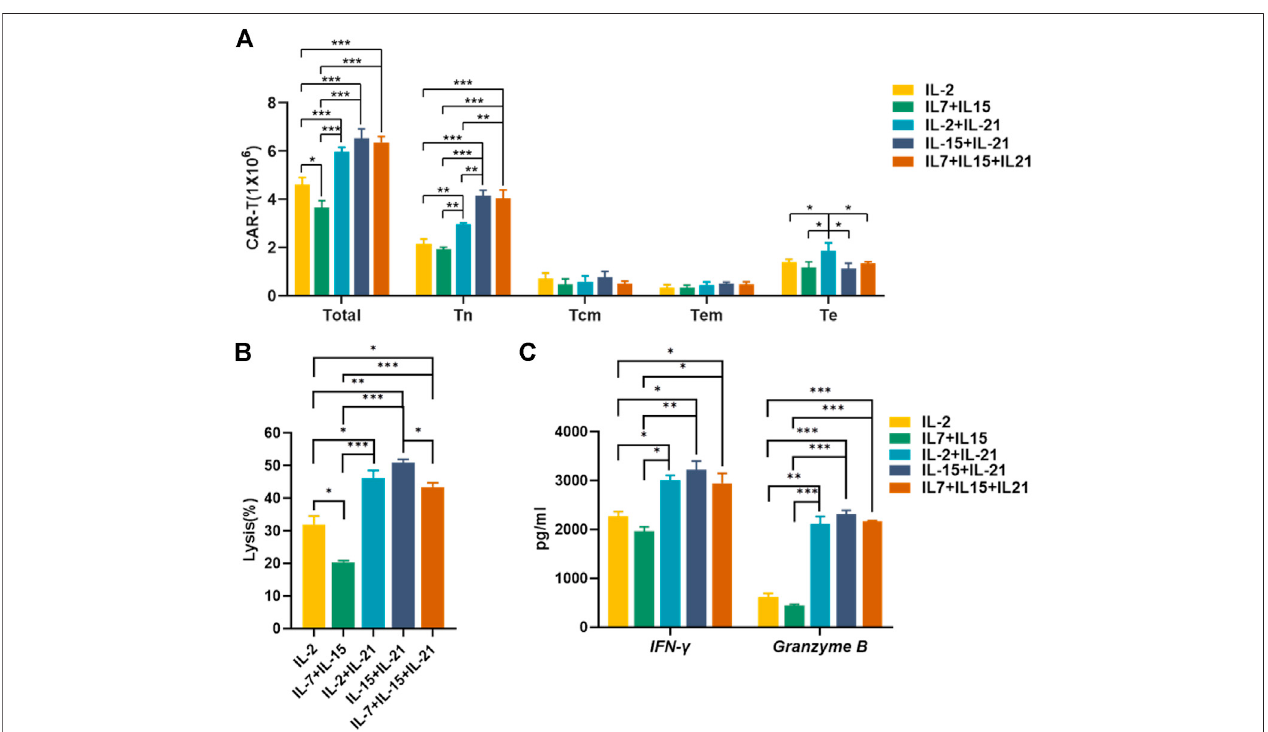
FIGURE 7 | IL-15+IL-21 is the optimal cytokine combination for the CAR-T cell preparation in vitro . (A) The absolute numbers of gated total CAR-T cells and different CAR-T subtypes were assessed on day 12 after transfection. (B) Cytotoxicity of HER-2-speci fi c CAR-T cultured under different cytokine conditions was evaluated by Calcein AM release assay after co-culture with SK-BR-3 for 6 h at an effector to target ratio of 2:1. (C) Supernatant was collected after 24 h co-culture of HER-2 CAR-T cells with SK-BR-3 at 2:1 effector-to-target ratio and assayed for IFN- γ and granzyme B release by ELISA. Each experiment was performed in triplicate. Mean values were calculated for each group. Error bars represent ± SEM. Statistical signi fi cance was calculated using Student t test, * p < 0.05, ** p < 0.01, *** p <